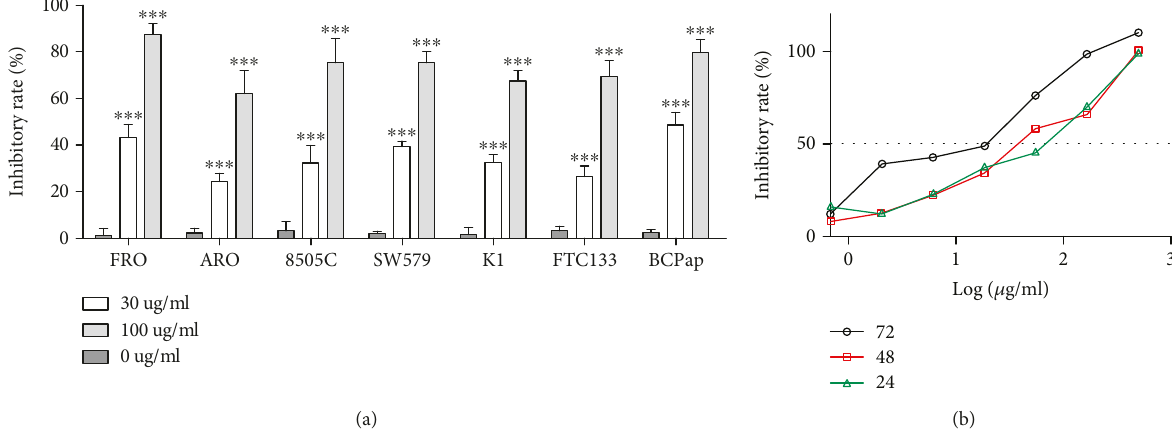
Figure 1: Inhibitory rate of thyroid carcinoma cell lines induced by CPP. (a) Inhibitory rates of a panel of thyroid carcinoma cell lines (FRO, ARO, 8505C, SW579, K1, FTC133, and BCPAP) that treated with CPP (0 μ g/mL, 30 μ g/mL, and 100 μ g/mL) are presented. (b) Inhibitory rates of FRO cells treated with CPP for 24 h, 48h, and 72h. The results were expressed as a percentage of the control, which was set at 100%. Data were presented as mean ± SD. ∗ p < 0 05 compared with control. ∗∗ p < 0 01 compared with control. ∗∗∗ p < 0 001 compared with control. All experiments were performed